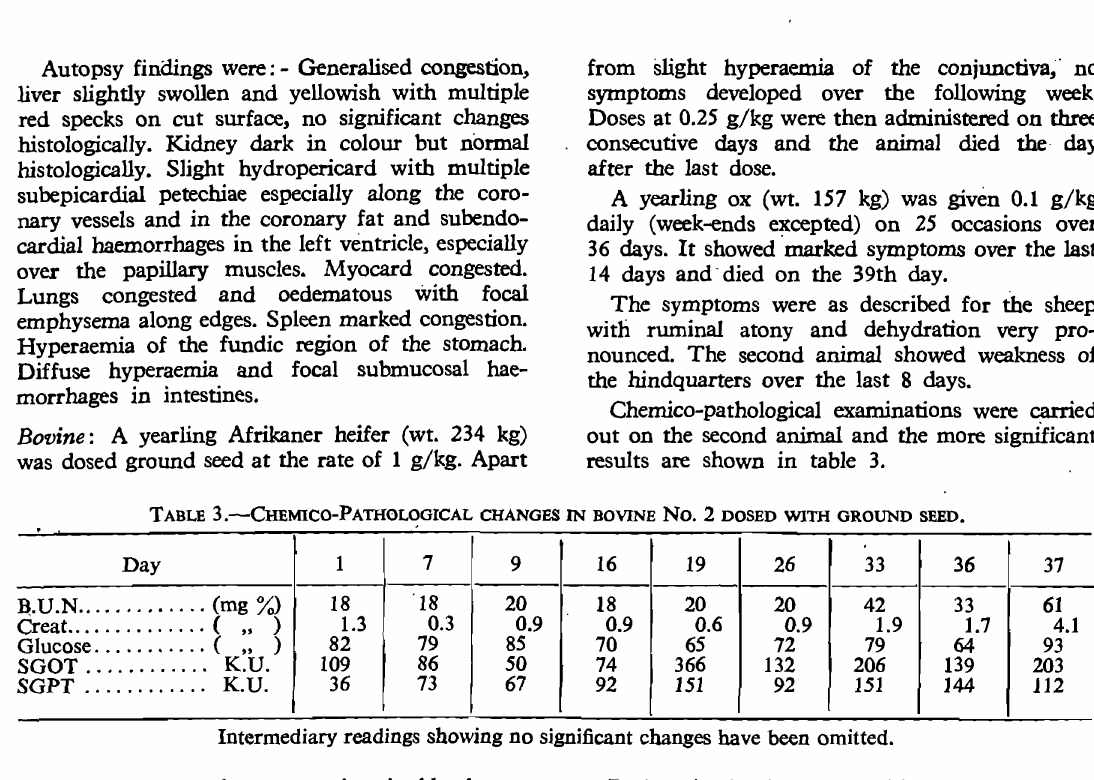
TABLE 4.-DoSAGE REGIME PrGS 2 AND 3 Days of Dosage